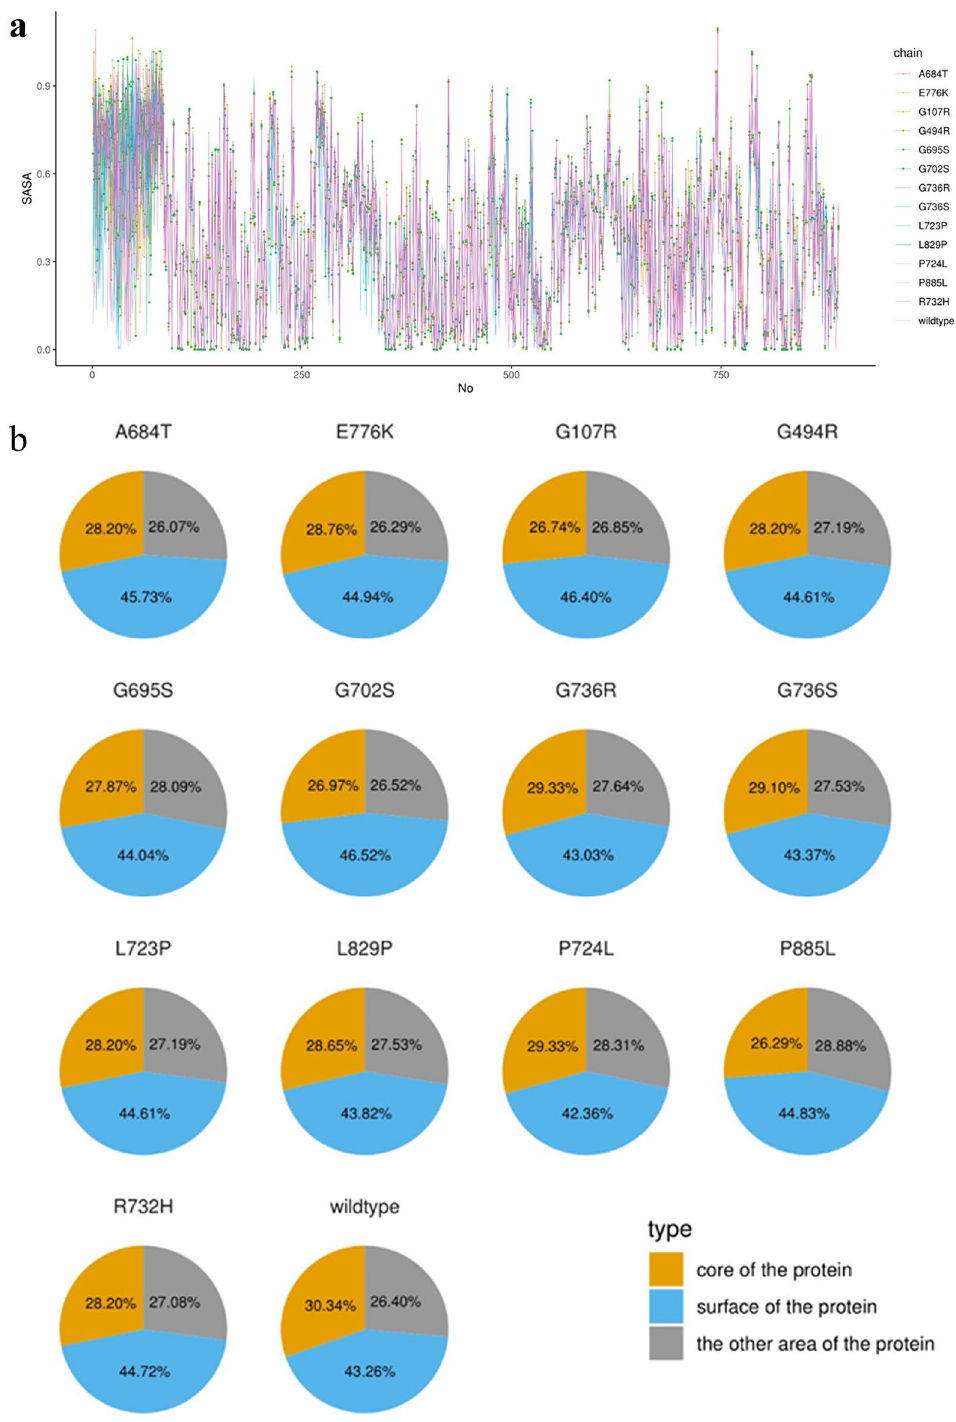
Figure 6. The solvent accessible surface areas of the wolframin protein. ( a ) The bottom panels describe per- residue SASA of wolframin protein and mutant proteins. ( b ) The distribution about the SASA of all 890 amino acids in wild and mutant